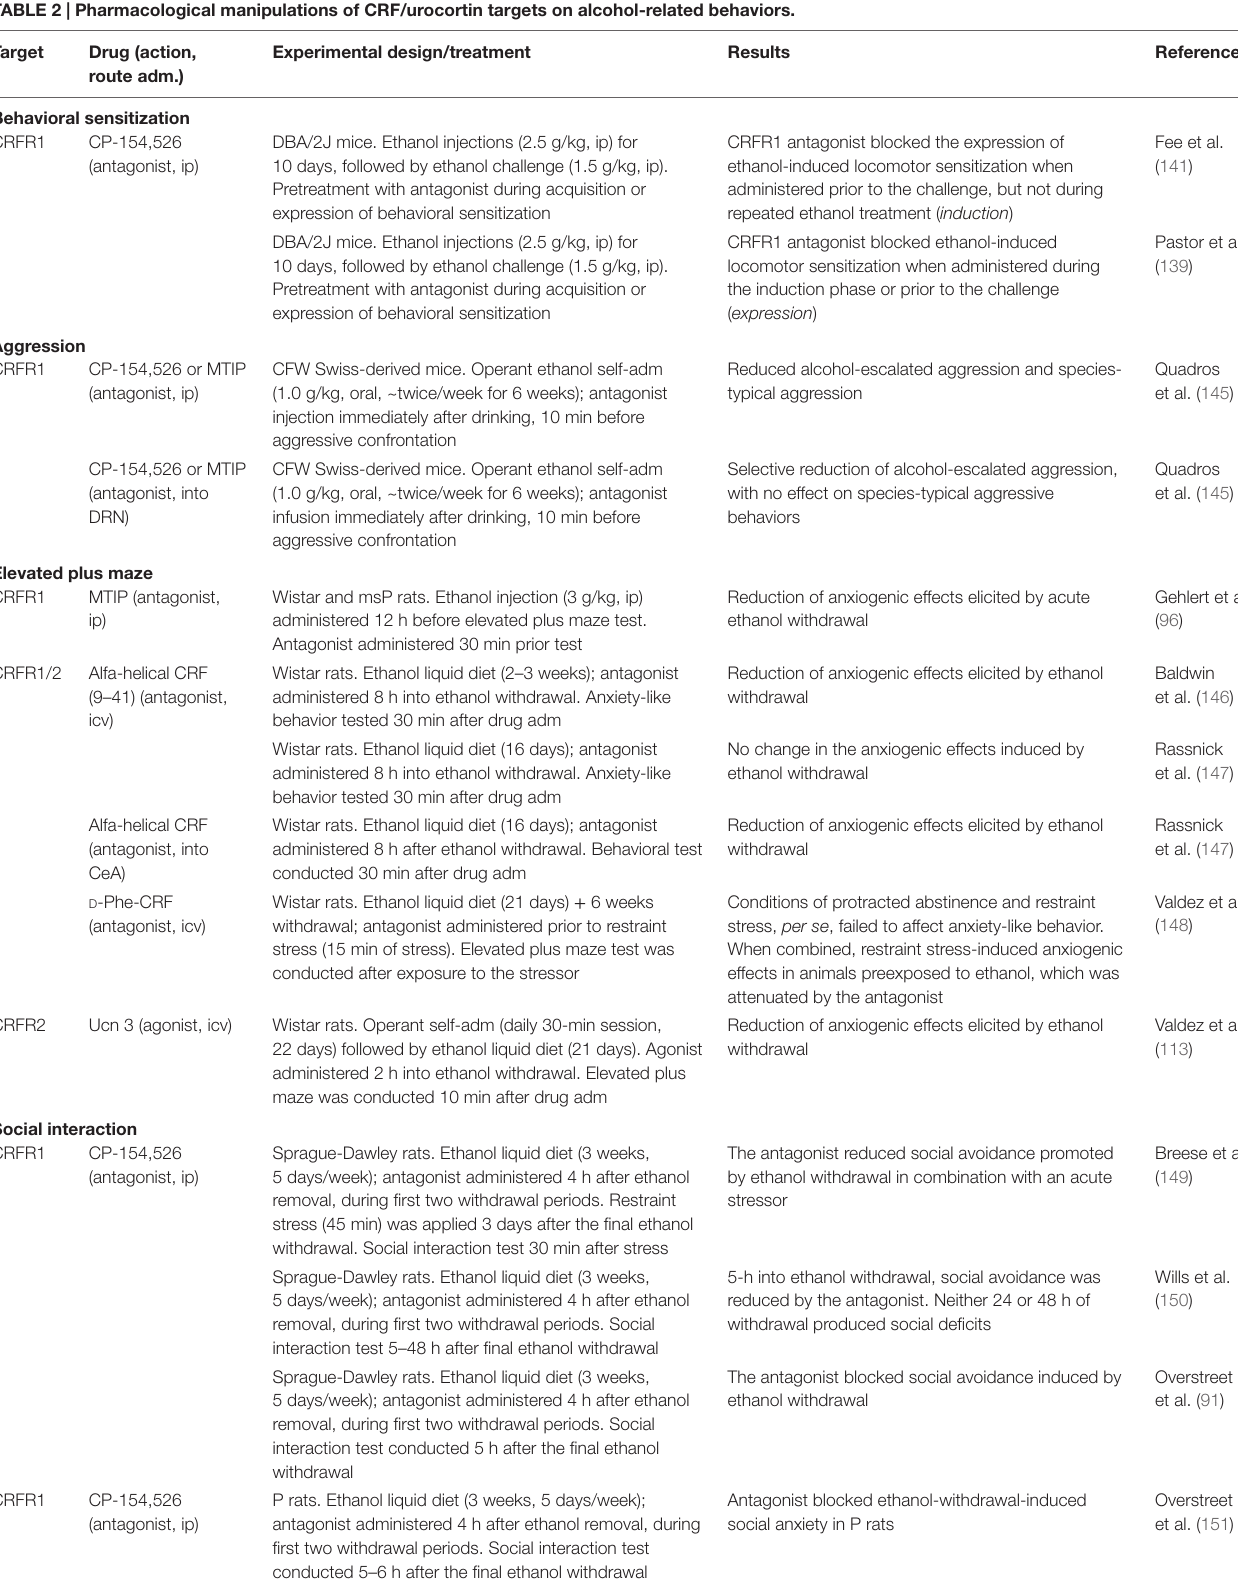
TABLe 2 | Pharmacological manipulations of CRF/urocortin targets on alcohol-related behaviors.